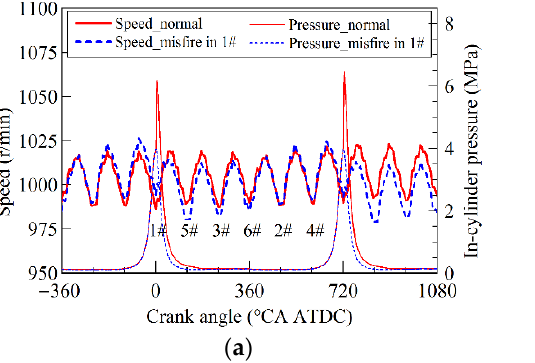
( b ) Figure 4. Instantaneous engine speed comparison between cylinder 1# misfire and cylinders 1# and 2# misfire conditions. ( a ) Under 1900 r/min and 100 Nm. ( b ) Under 2000 r/min and no-load condi- tion. Therefore, for detecting misfire accurately, the fault features that can reduce or elim- inate the interference from engine speed and load should be found. One way to eliminate the impact of engine running range is to divide it into small blocks and then find fault features for each block [27]. However, this will increase workload when the engine run- ning range is large. The better way is to find or design an algorithm that can extract useful feature or can learn more features for the whole engine running conditions. An example of the traditional methods which is called engine roughness method is introduced as below. This method calculates a misfire indicator that is based on the dif- ference of two consecutive angular accelerations. Equation (1) presents the calculation of the indicator [10]. (1) where S i is engine roughness of the i th cylinder. T i is the time period from ignition of the i th cylinder to ignition of the next cylinder in firing order. Figure 5 shows the results of indicator S under different engine speeds and different misfire patterns. When misfire occurs in cylinder i , the corresponding S i will become larger than the predefined threshold. An example is shown in Figure 5a, the threshold can be defined in range 15–19, and when S i is detected larger than the threshold, it is thought the misfire happened in the cylinder i . This method is limited at the high-speed low-load conditions. As shown in Figure 5b, under 1900 r/min and no-load condition, it is hard to determine the threshold, and the two-cylinder misfire modes are easily confused with one-cylinder misfire modes.